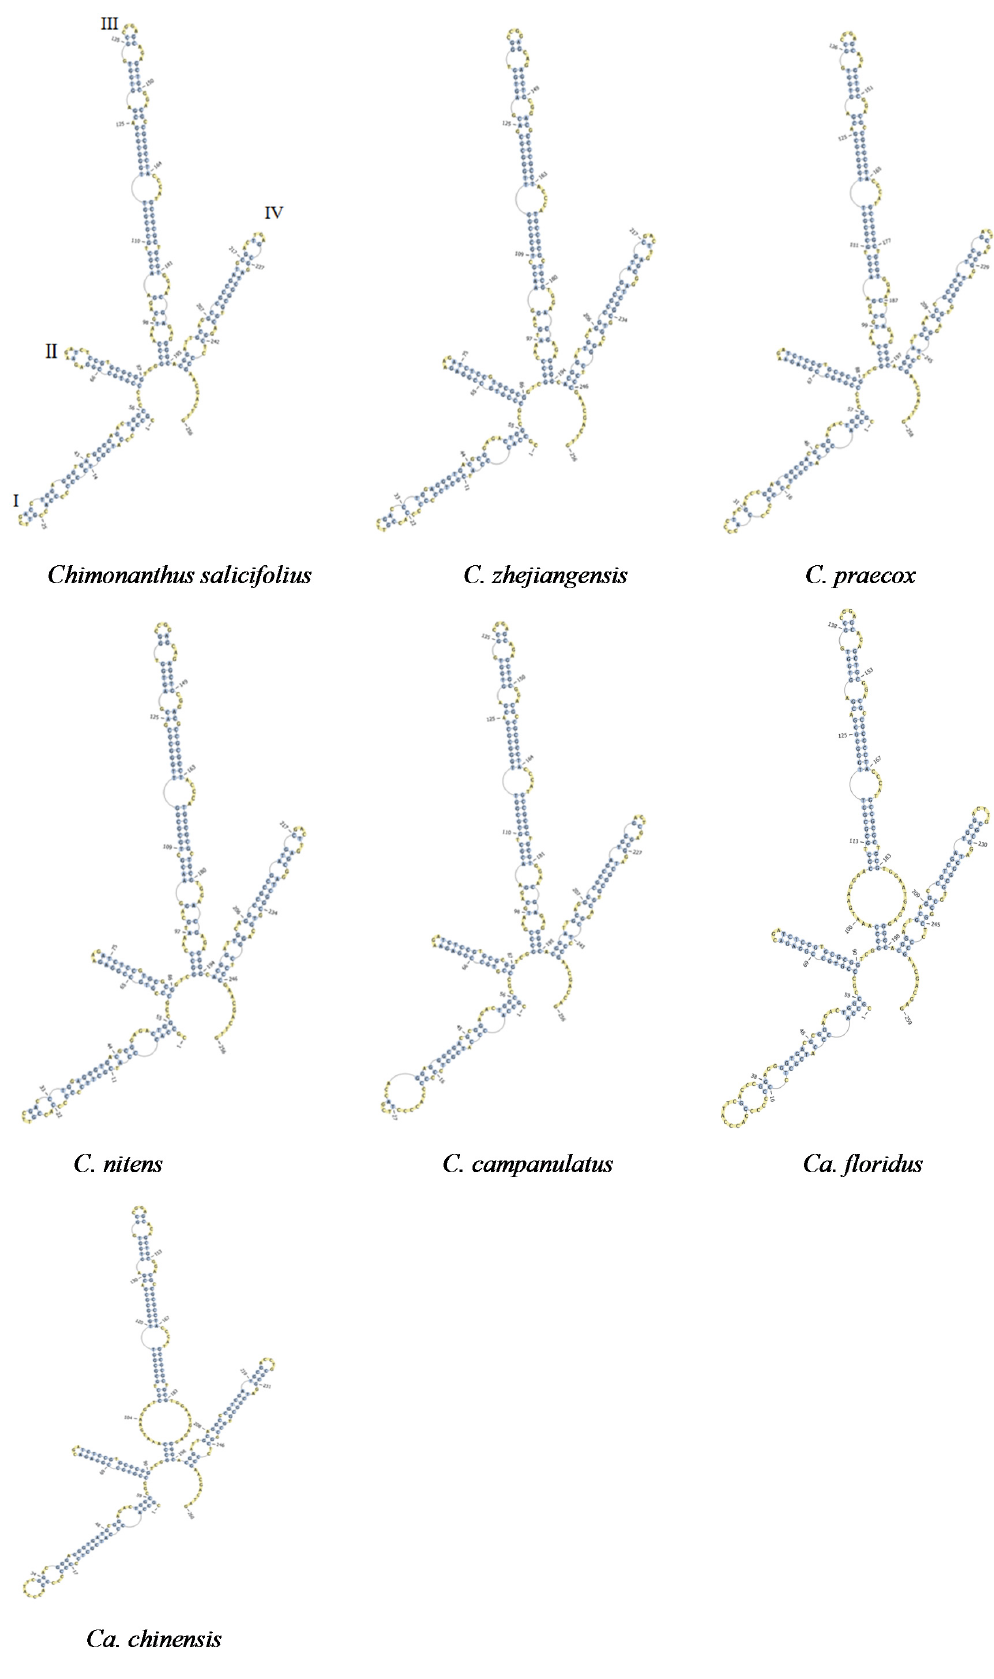
Figure 2. The ITS2 secondary structure of Shi ‐ Liang tea and its closely related species.